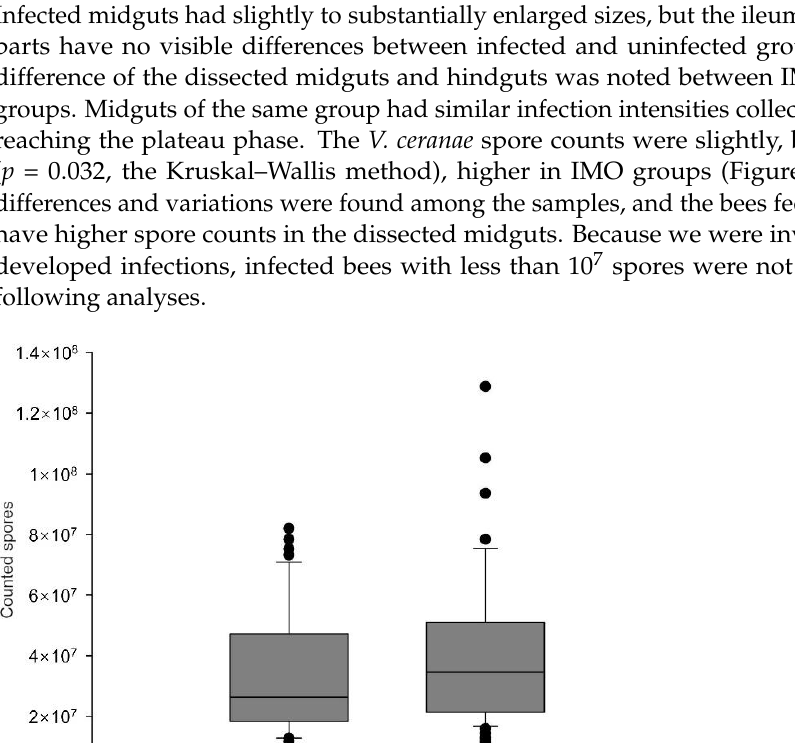
Figure 2. Survival analysis using the Kaplan–Meier method of the four treatment groups. Only the group inoculated with sucrose showed a significant increase in mortality.